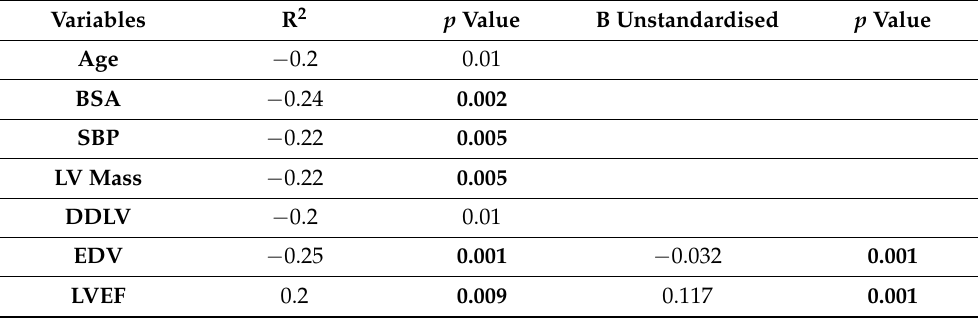
R 2 : Determination coefficient, BSA body surface area, SBP systolic blood pressure, LV left ventricle, DDLV end diastolic diameter of left ventricle, EDV end diastolic volume, LVEF left ventricular ejection fraction biplane by Simpson. Variables that reached p -values < 0.01 in the univariate model and did not show collinearity with other variables (VIF < 5) were included in the multivariate model. In cases of collinearity, the variable with the highest correlation coefficient was included in the multivariate model. If a variable included in the multivariate model did not reach statistical significance, it was excluded by backward steps. r = 0.322, R 2 = 0.104 and corrected 0.091 for the multivariate regression model, p : 0.001. Bold value indicates p -values <